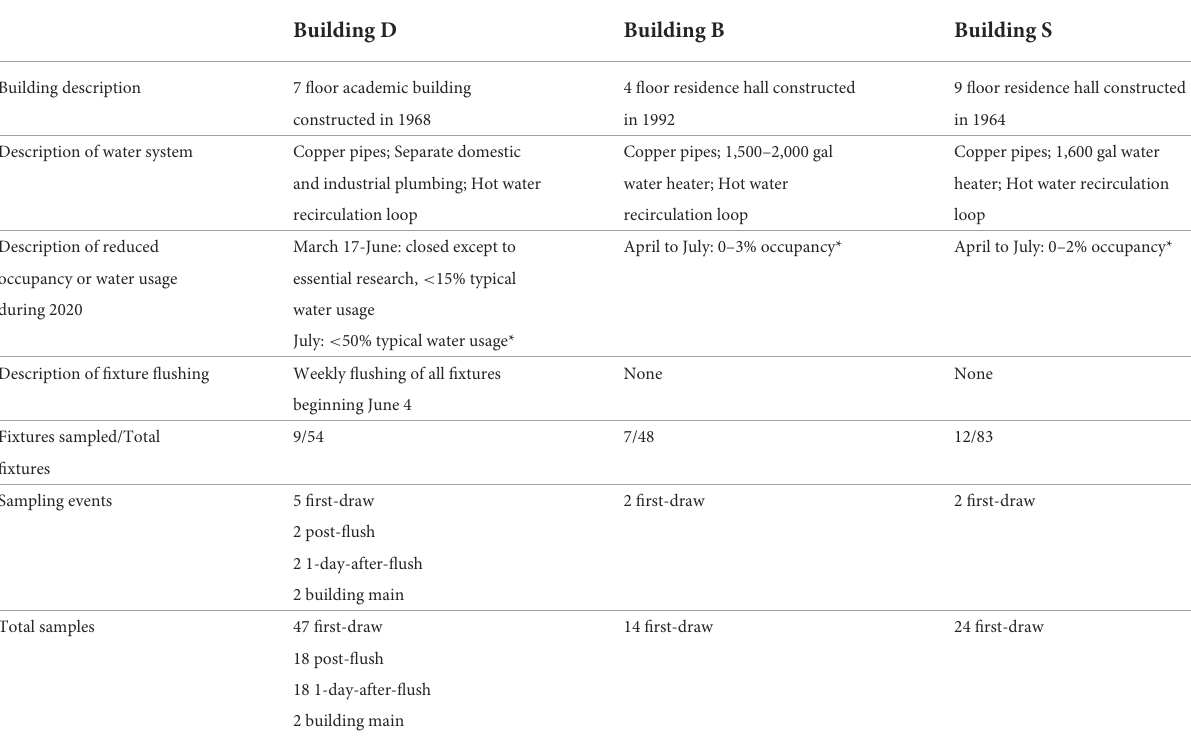
TABLE 1 Descriptions of study buildings, conditions, and sampling